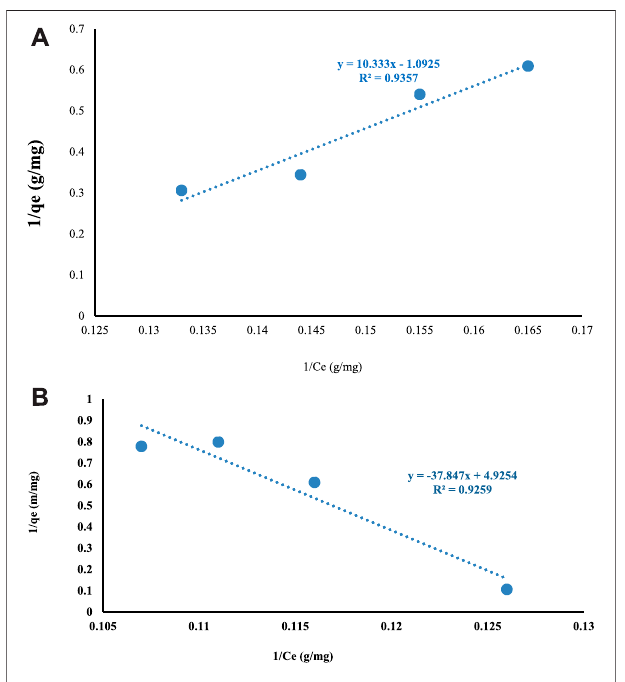
FIGURE 12 | Langmuir isotherm plot of adsorption (A) Chromium (B) Lead on OP/Se nanocomposite.